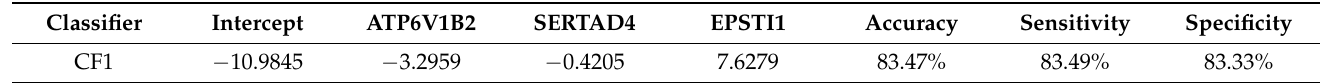
Table 7. Second dataset: Characteristics of the top-performing five-gene classifier. CF1 stands for the first individual classifier for COVID-19-positive vs. COVID-19-negative